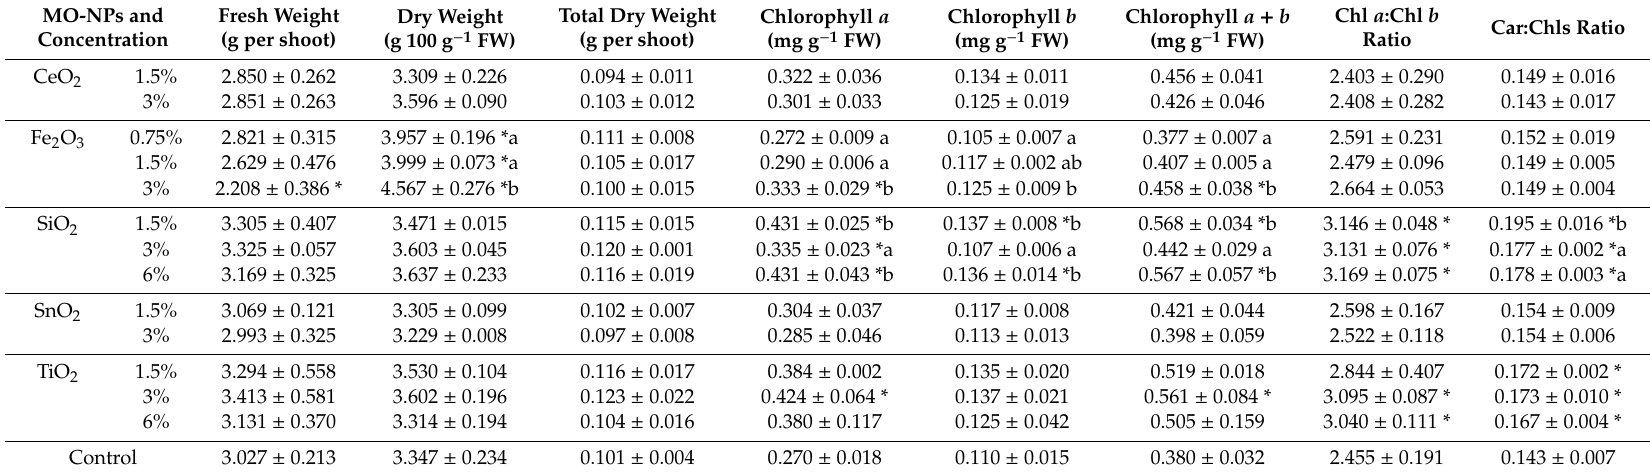
Table 1. Fresh and dry weight of oakleaf lettuce seedlings, content of chlorophyll pigments in the plants, and Chl a :Chl b and Car:Chls ratios depending on engineered nanoparticles (nano-metal / metalloid oxides; MO-NPs) applied to the leaves at di ff erent concentrations. Control plants were sprayed with deionized water. MO-NPs and